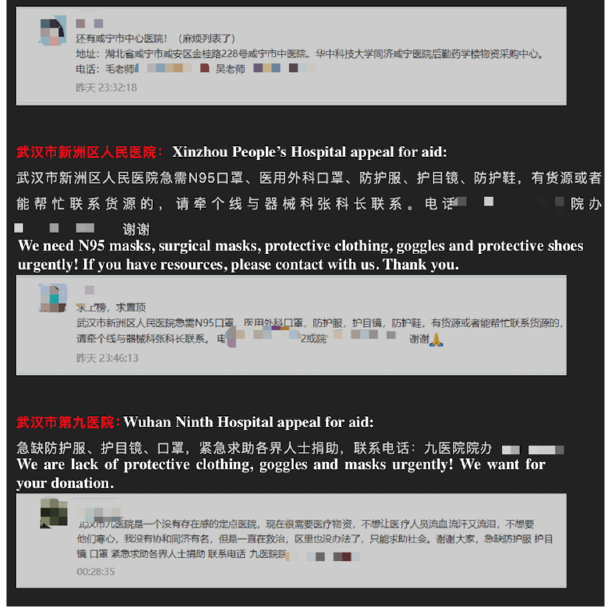
Figure 9. Screenshot of other types of articles. From: YiXueJie. Except for 18 tertiary hospitals in Wuhan, there are still many hospitals in Hubei appealing for help. Please share this